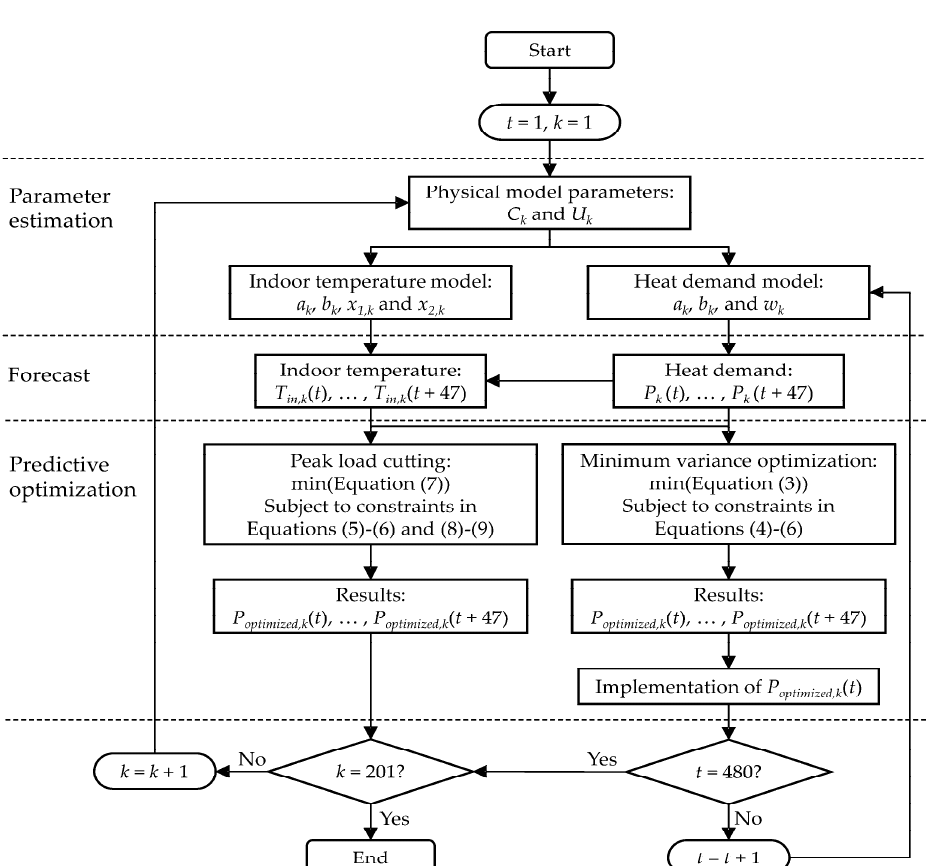
Figure 2. Predictive optimization of the heat demand with two different optimization strategies.